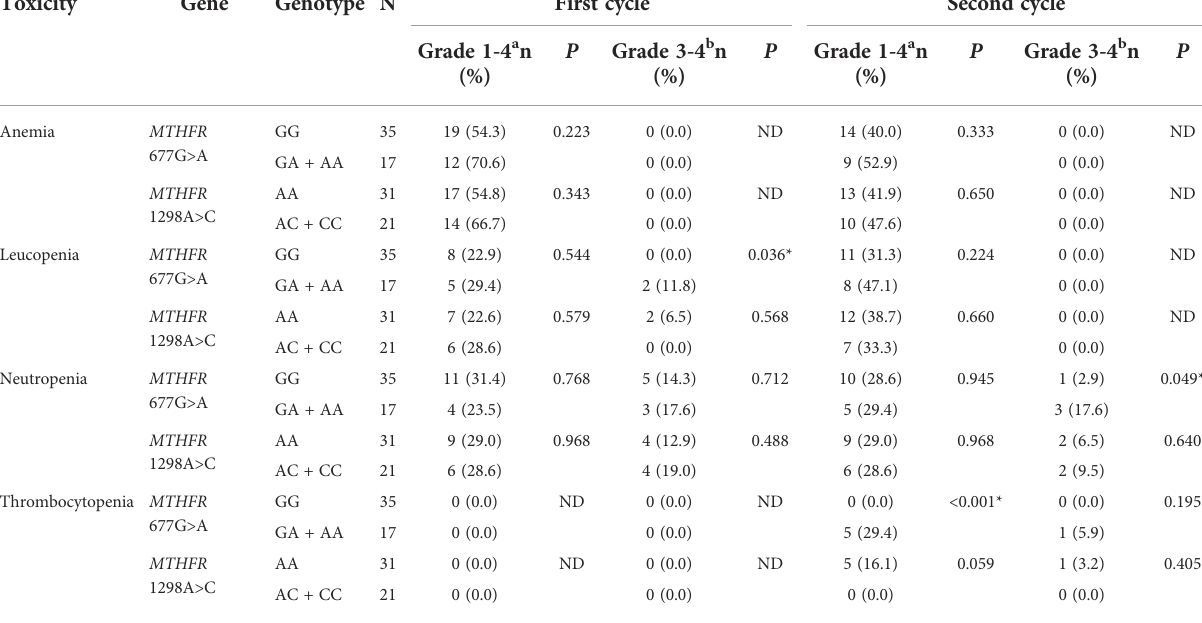
TABLE 3 Different grades of toxicities in fi rst and second cycles (N=52) caused by 5-FU-based chemotherapy in the patients with different genotypes of MTHFR polymorphism. Toxicity